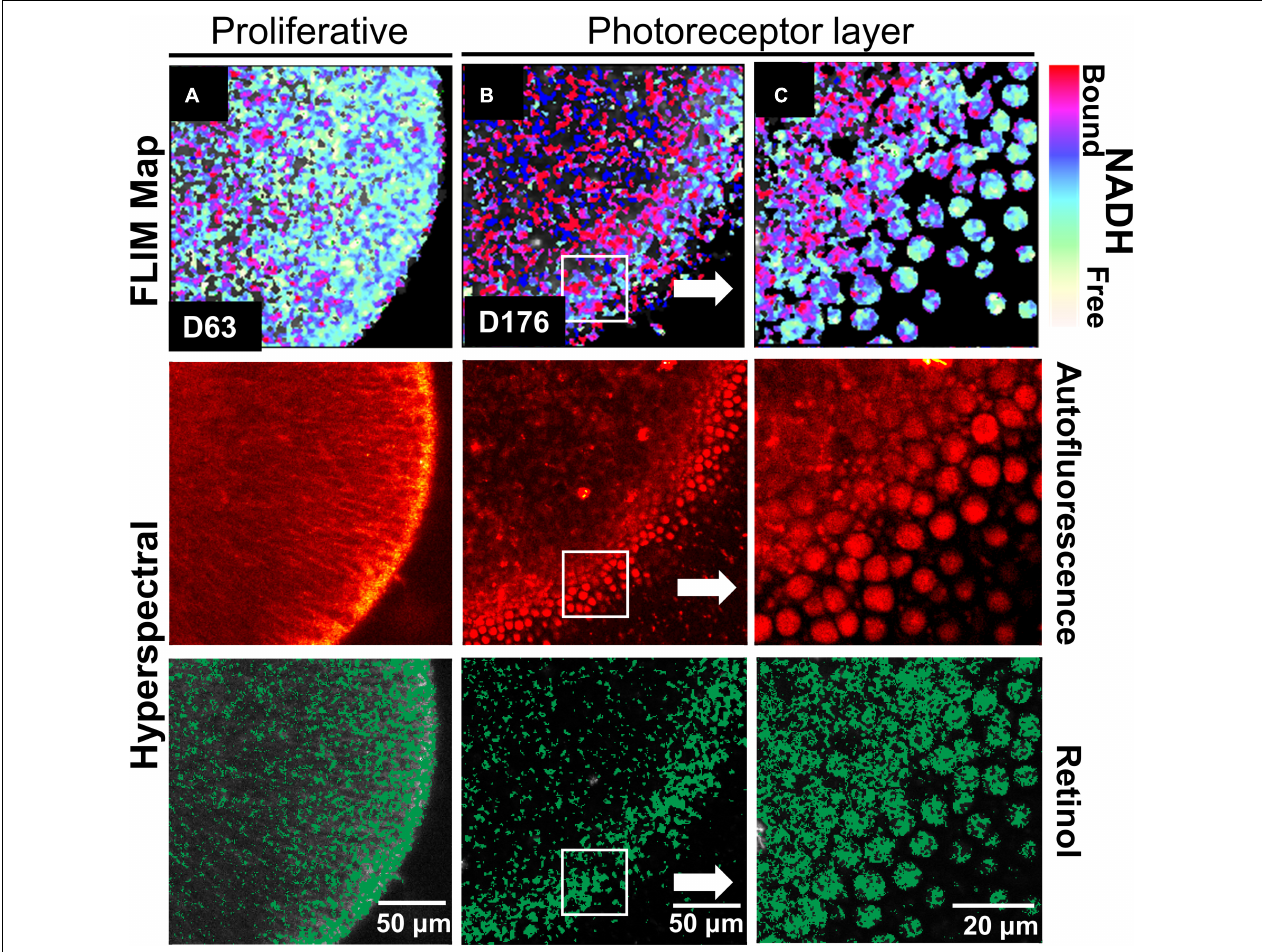
FIGURE 2 | Functional imaging results of CRX-GFP hESCs derived RtOgs. FLIM and HSpec images of a typical RtOg are shown. RtOgs on (A) D63 and (B) D176 of differentiation. (C) The magnified view of the outer surface of the RtOg on